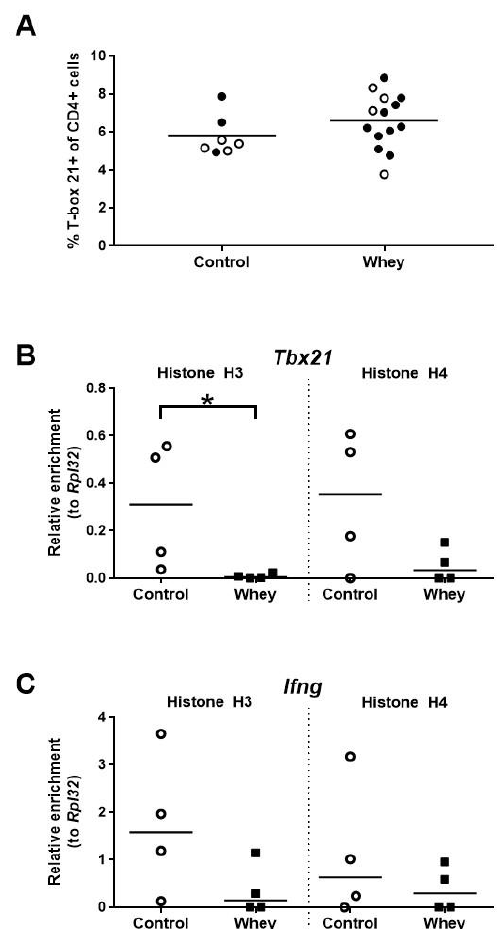
Figure 4. A confirmed allergic response to whey protein was associated with an unaltered percentage of Th1 cells in the spleen and decreased H3 histone acetylation levels at a gene encoding T-box 21 in spleen-derived CD4 + T cells. ( A ) The percentage of CD4 + T cells positive for T-box 21 (T-bet) as assessed by flow cytometry. Data are presented as a scatter dot plot showing individual data points and mean. Open circles indicate the mice which were included in the histone modification analysis. Comparisons were performed with an unpaired t test. Histone acetylation levels at the T-box 21 gene ( Tbx21 ) ( B ) and the interferon γ gene ( Ifng ) ( C ) in spleen-derived CD4 + T cells as determined by chromatin immunoprecipitation followed by qPCR. Data are presented as scatter dot plots showing individual data points and median. Comparisons were performed with a Mann–Whitney U test. * p < 0.05.